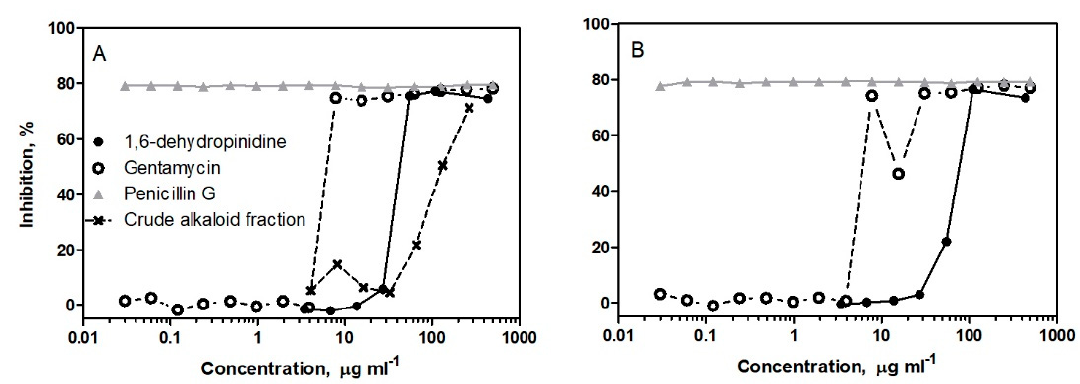
Figure 5. The inhibition activity (%) of the 1,6-dehydropinidine fraction and control antibiotics (gentamycin and penicillin G) against S. equi after ( A ) 24 h and ( B ) 48 h incubation in Mueller-Hinton broth. The inhibition of the crude alkaloid fraction of sprout alkaloids after 24 h is presented as a reference for 1,6-dehydropinidine. The concentrations of the studied compounds are expressed on a log10 scale.